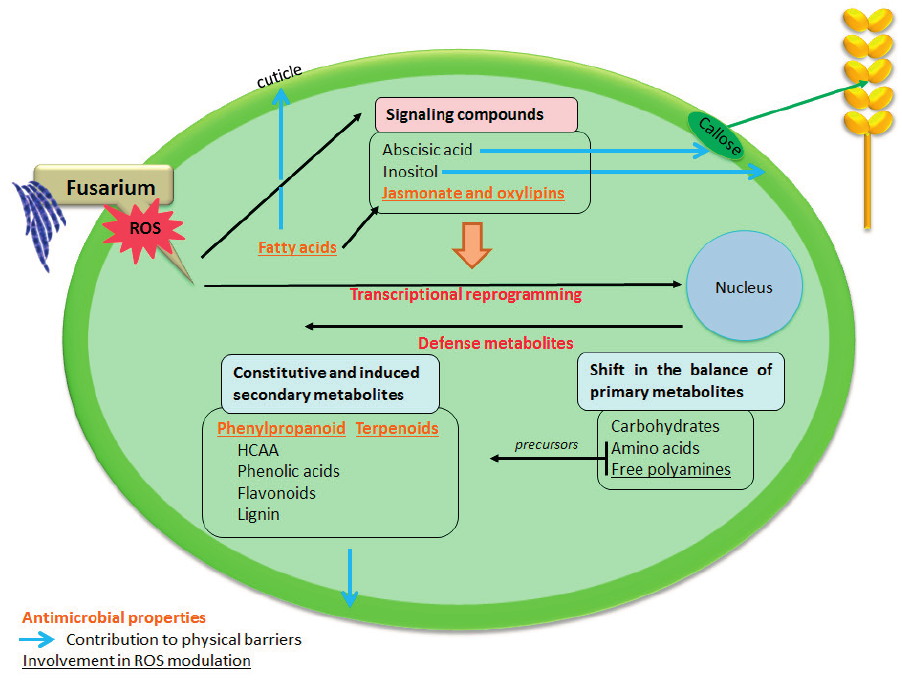
Figure 2. Overview of the key metabolites cereals could employ to counteract F. graminearum . (ROS: Reactive Oxygen Species, HCAA: Hydroxycinnamic Acid Amides). Compounds in bold orange are compounds with antimicrobial properties, underlined are contributing to ROS modulation and the blue arrows symbolize the participation to reinforcement of physical